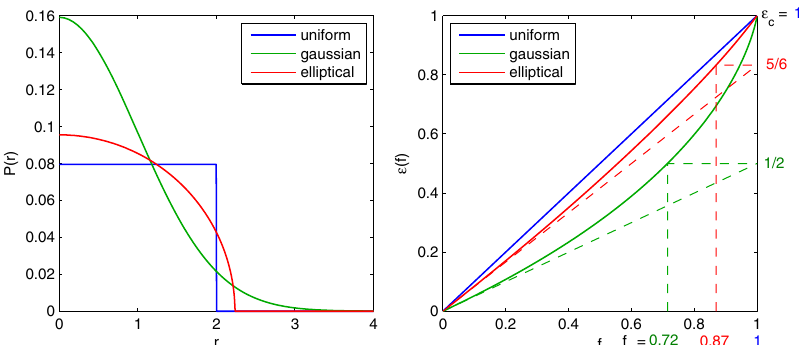
FIG. 8. Radial phase-space distributions (left) and corresponding emittance vs fraction curves (right). All distributions are scaled to have (cid:7) ¼ 1 . Core fraction and emittance for different distribution types are shown as